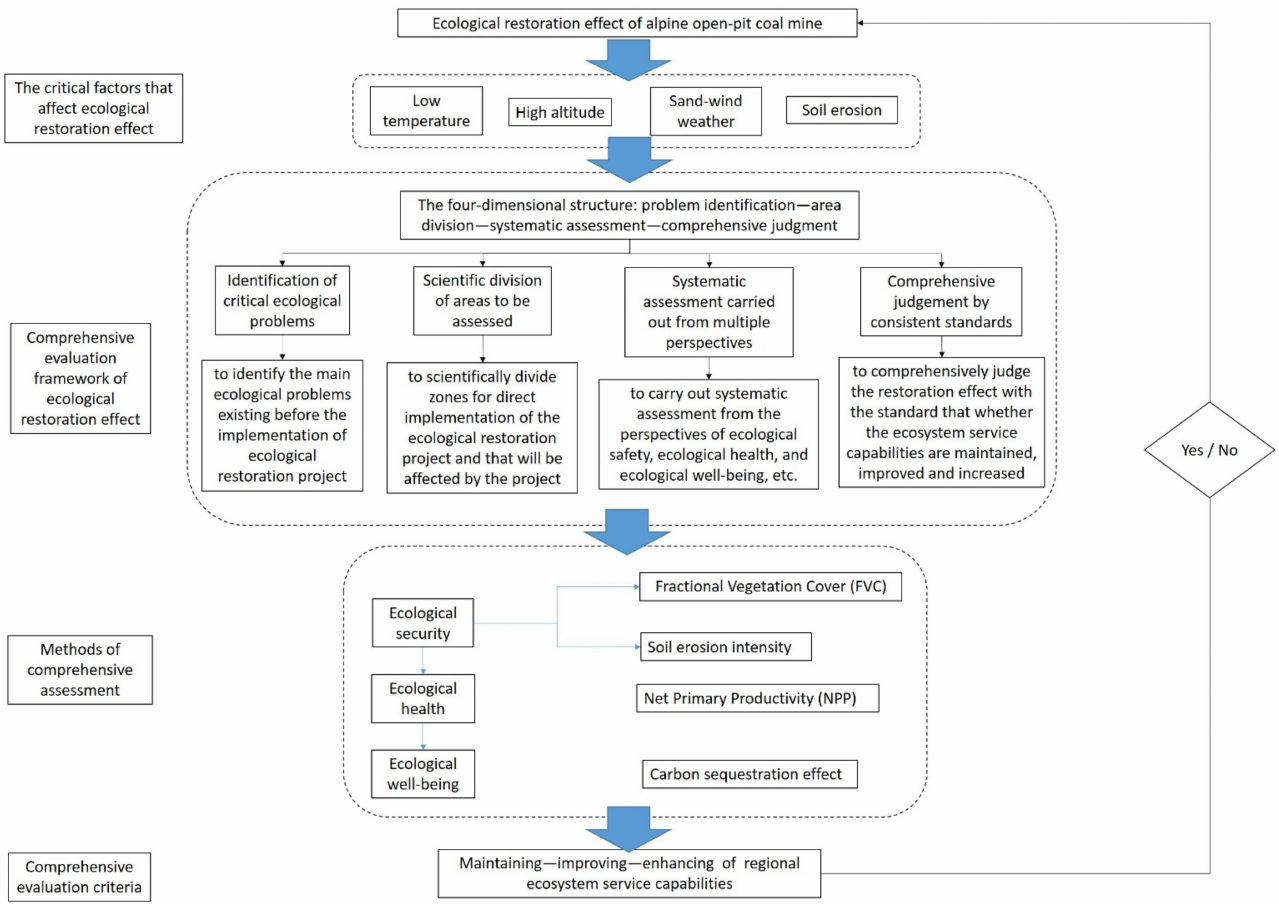
Figure 3. Ecological restoration effect assessment model of an alpine open-pit coal